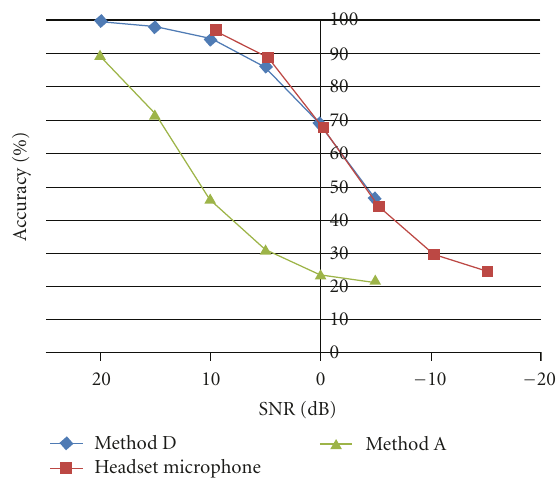
Figure 6: The Performance of the proposed method (Method D) with the headset microphone and the single microphone (Method A) in the microphone